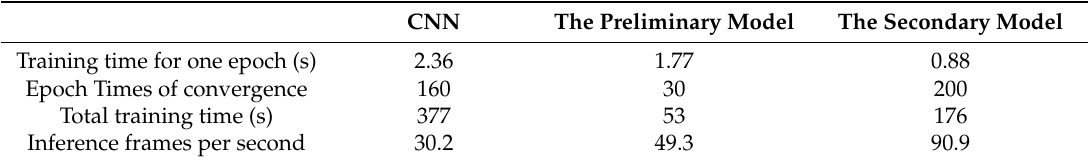
Table 4. Model training and inference time of CNN and WCNN in fluorochemical engineering processes. CNN The Preliminary